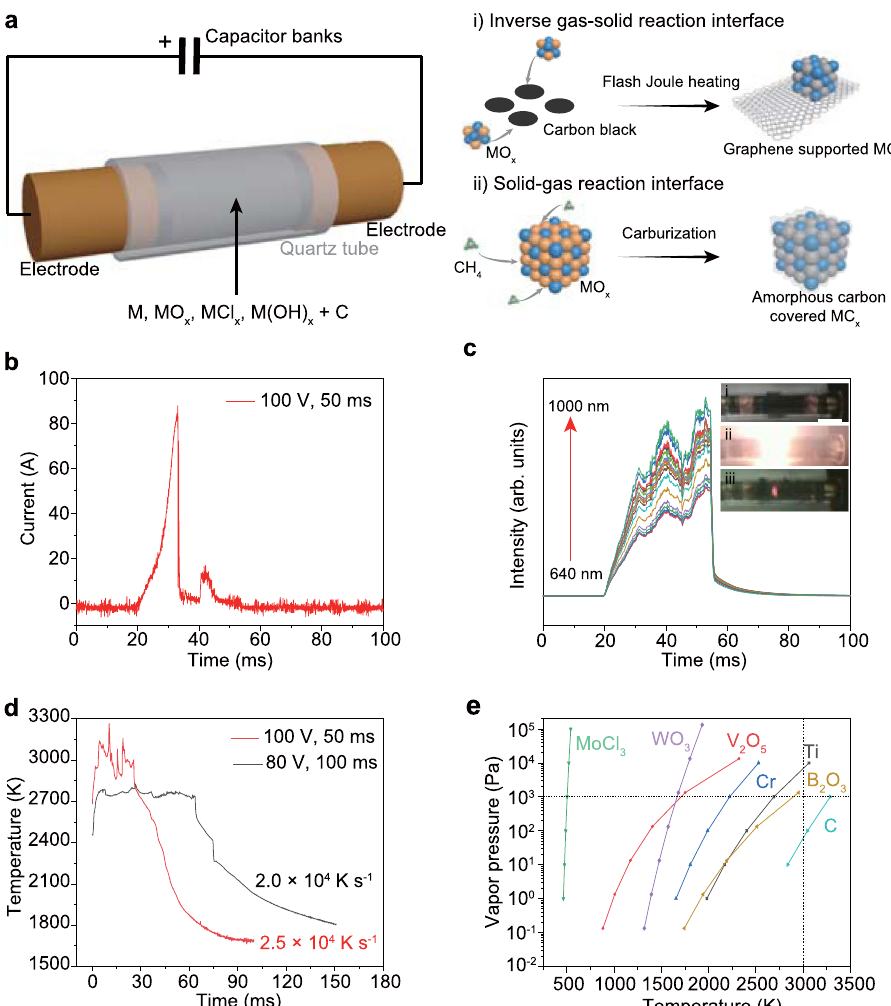
Fig. 1 Ultrafast synthesis of carbides by fl ash Joule heating (FJH). a Schematic of FJH synthesis of carbides. Route (i) demonstrates the high-temperature FJH process disclosed here. Route (ii) demonstrates the traditional carburization process. b Current measurement during the FJH process. c Real-time spectral radiance at wavelength of 640 – 1000 nm. Inset, the pictures of the sample before FJH (i), during FJH (ii), and in rapid cooling (iii). Scale bar, 1 cm. d Real-time temperature measurement by fi tting the blackbody radiation from the sample during the FJH process. e Temperature-vapor pressure relationships for various metal precursors and carbon. The vertical dashed line denotes temperature at 3000 K, and the horizontal dashed line denotes vapor pressure at 10 3